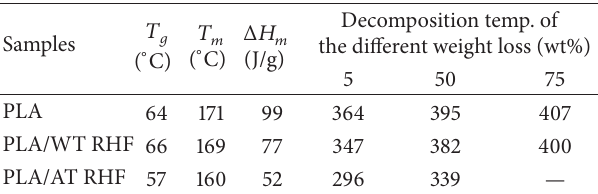
Table 8: DSC and TGA results of WT RHF and AT RHF filled PLA